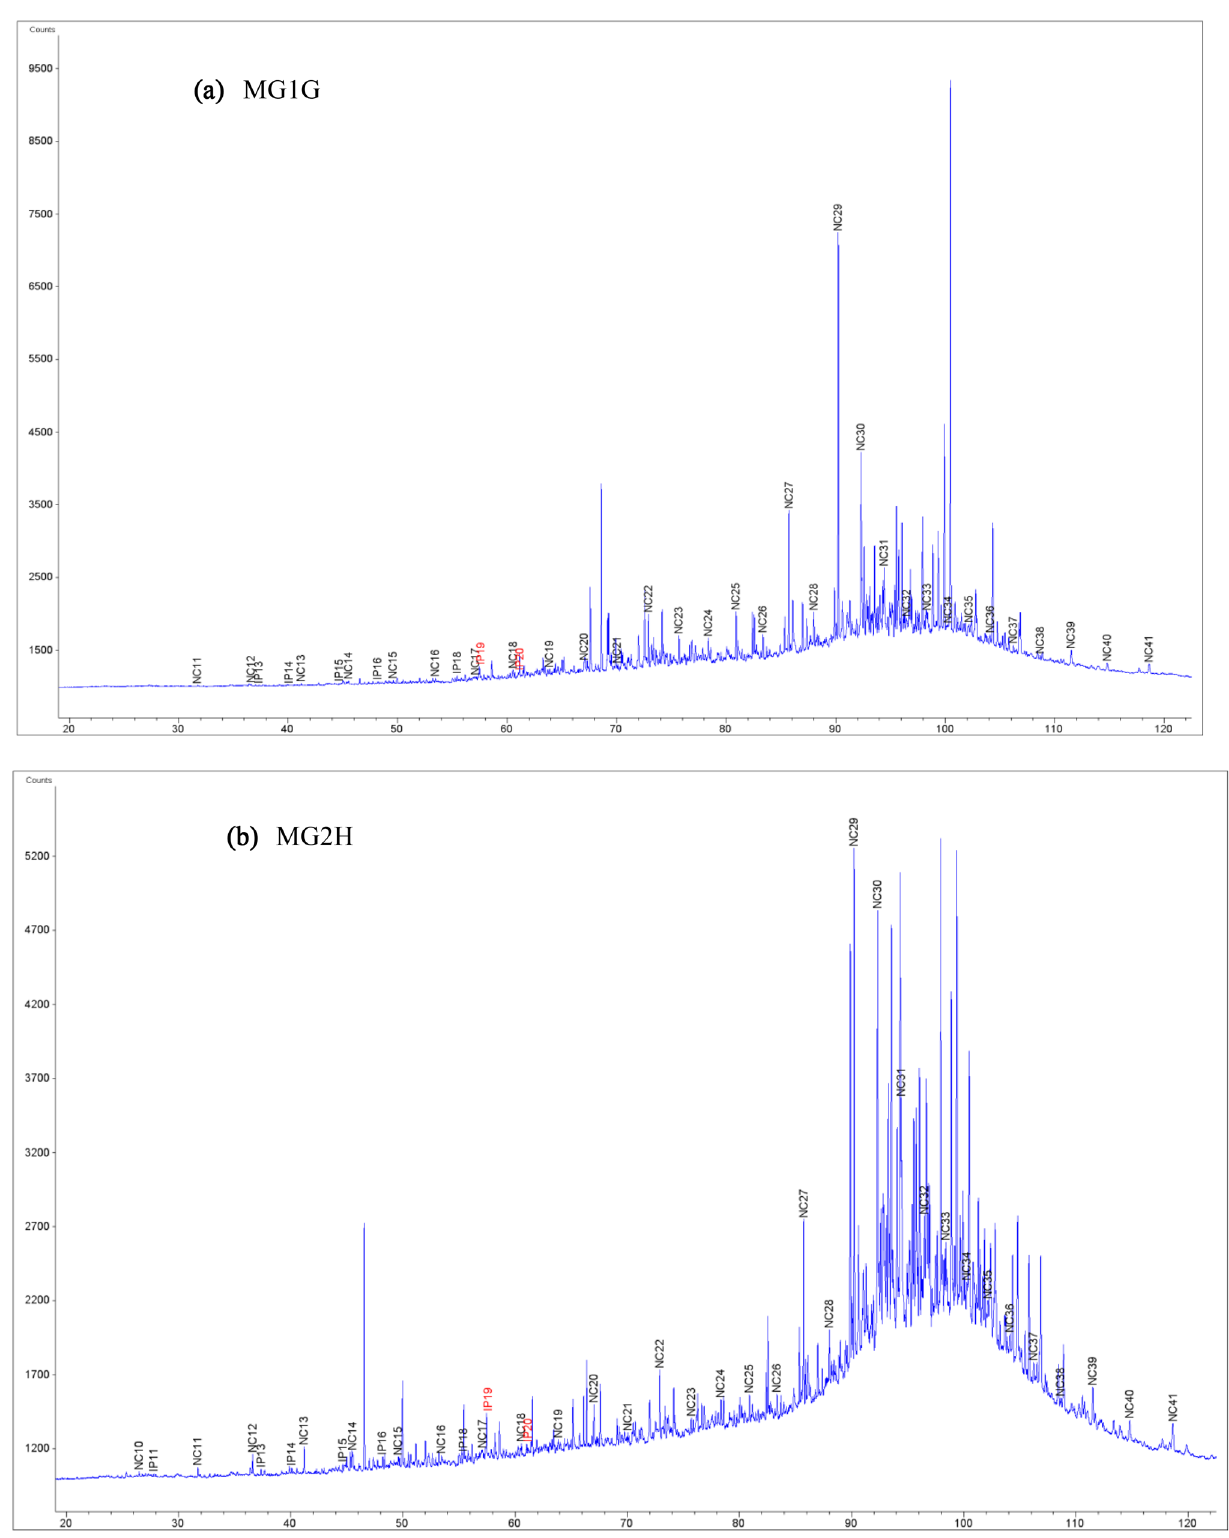
Fig. 13 Ion chromatograms of samples showing the distribution of n -alkanes. a MG1G, b MG2H, c MG2O, d MG4K, e MG3S, f MG4D, g